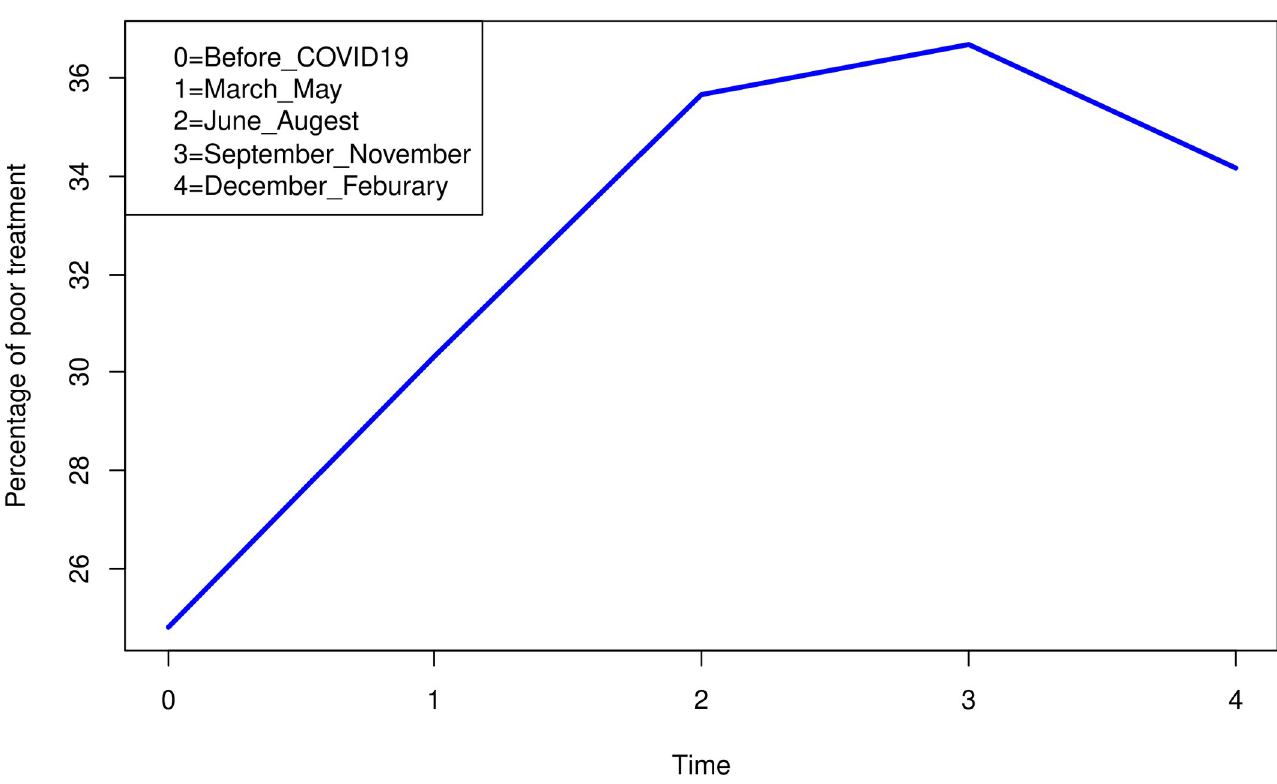
Fig 1. The proportion of poor treatment outcomes among ambulatory Diabetic and/ or Hypertensive patients in Northwest Ethiopia, 2021 (n = 836).